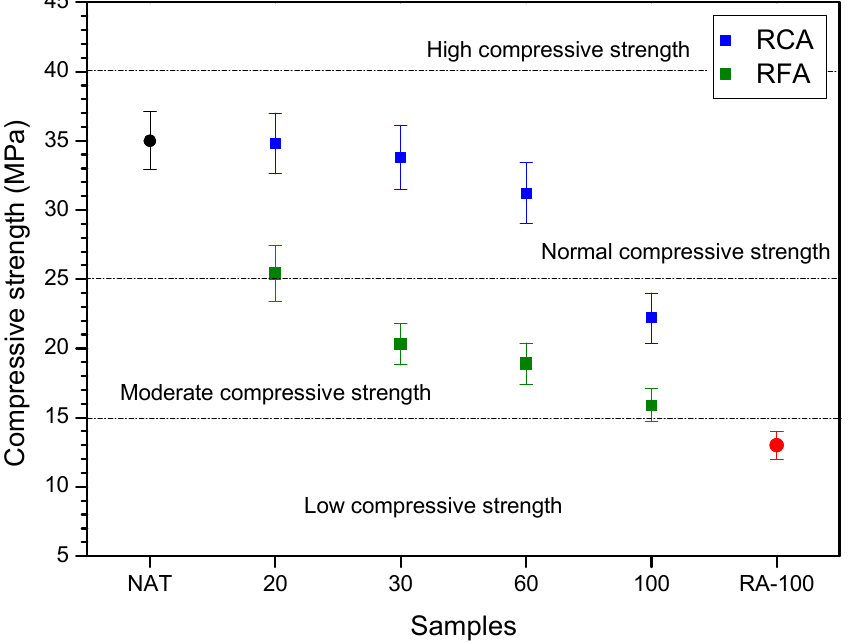
Figure 7. Compressive strength of the studied